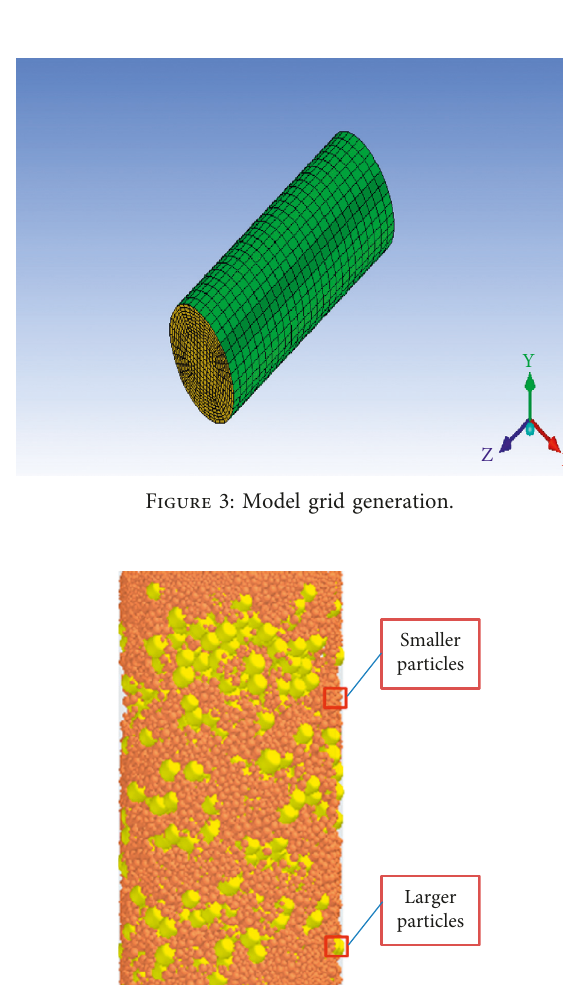
Figure 2: EDEM-FLUENT coupling numerical calculation model.